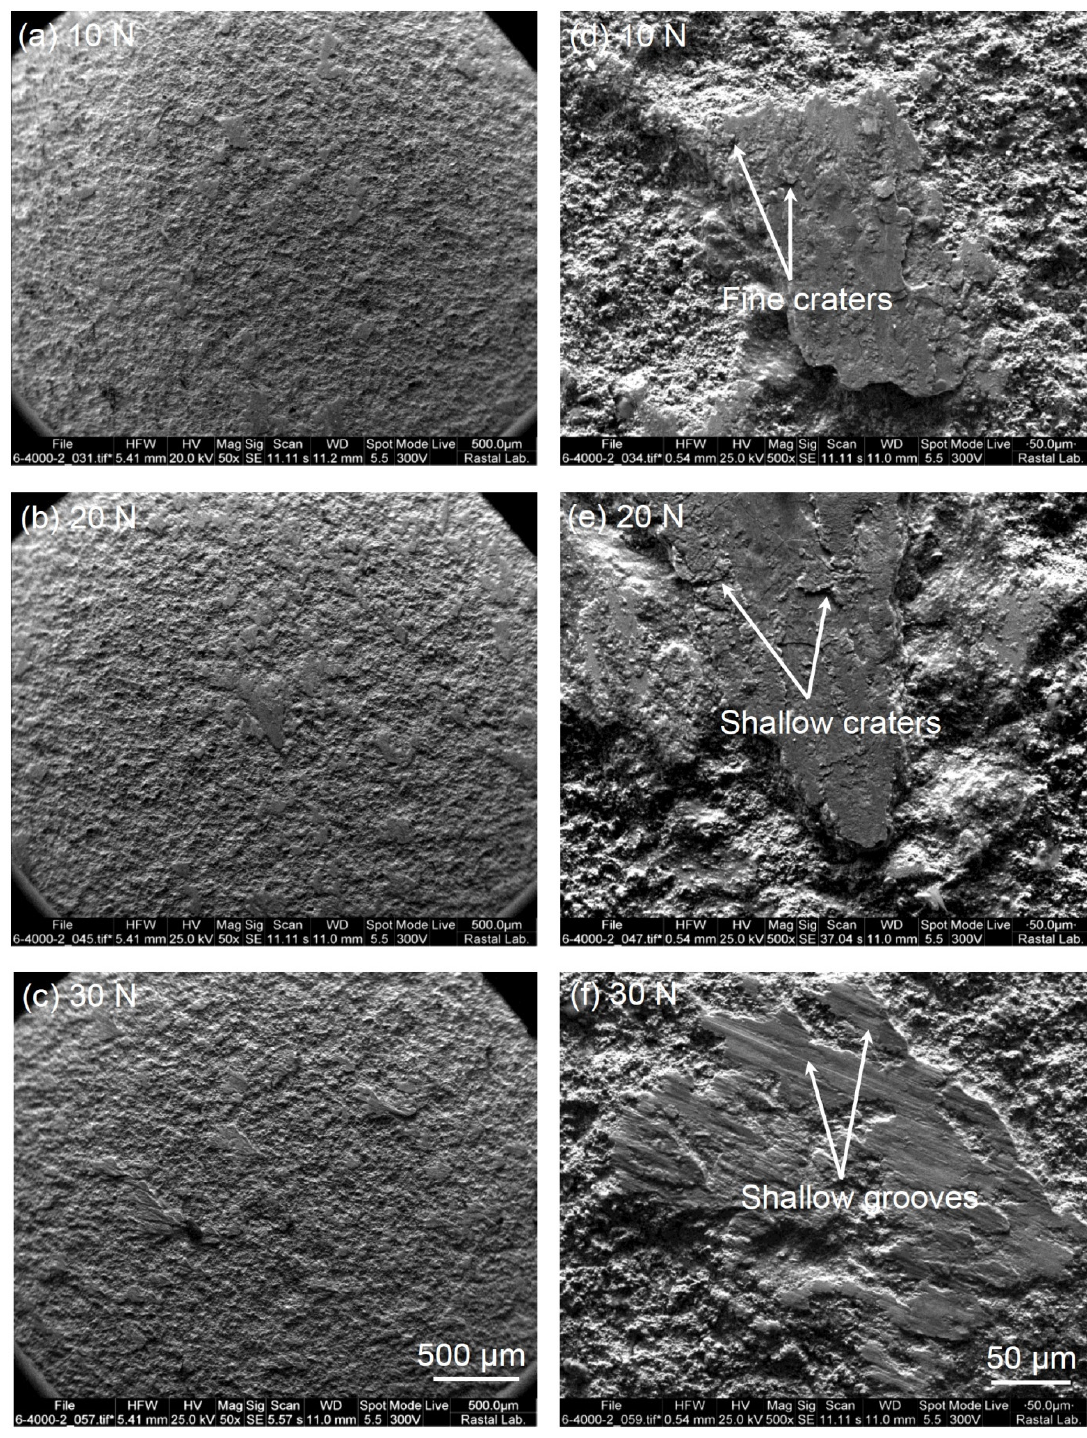
Figure 13. ( a – c ) Low and ( d – f ) high magnification SEM micrographs on worn surfaces of WC-Co-Cr coating under different applied